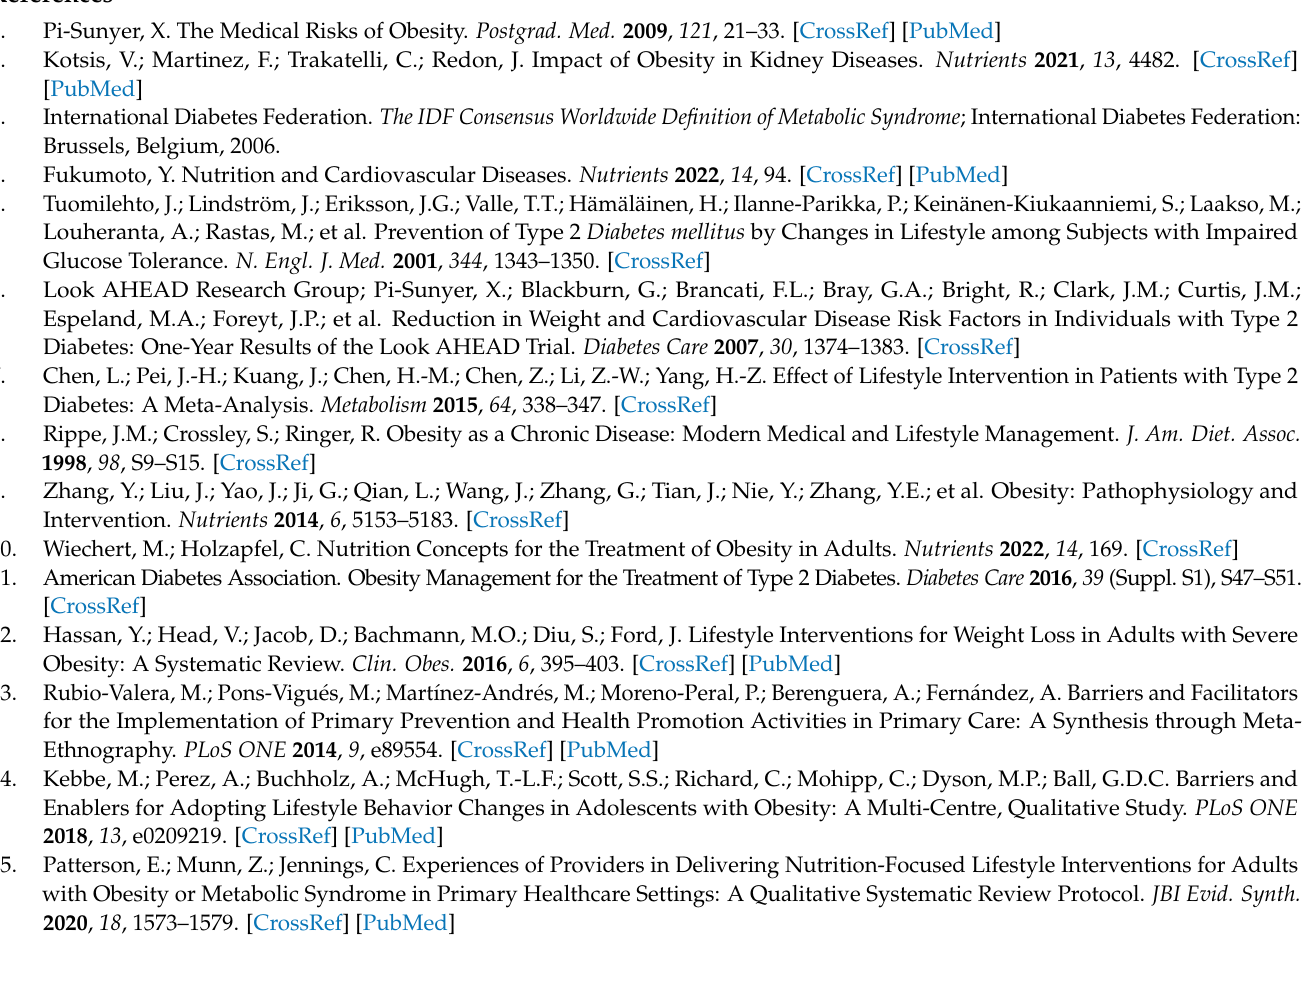
Figure A4. In-app peer support group.